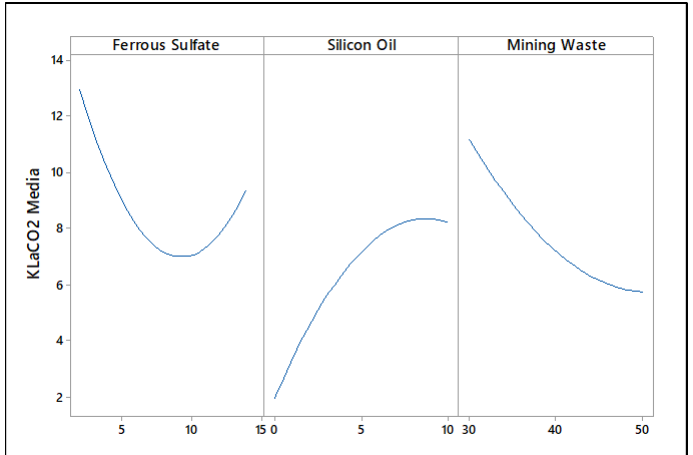
Figure 4. k LaCO2 main effects plot (adjusted media) of ferrous sulfate (g/L), silicon oil (%), and mining waste (%).